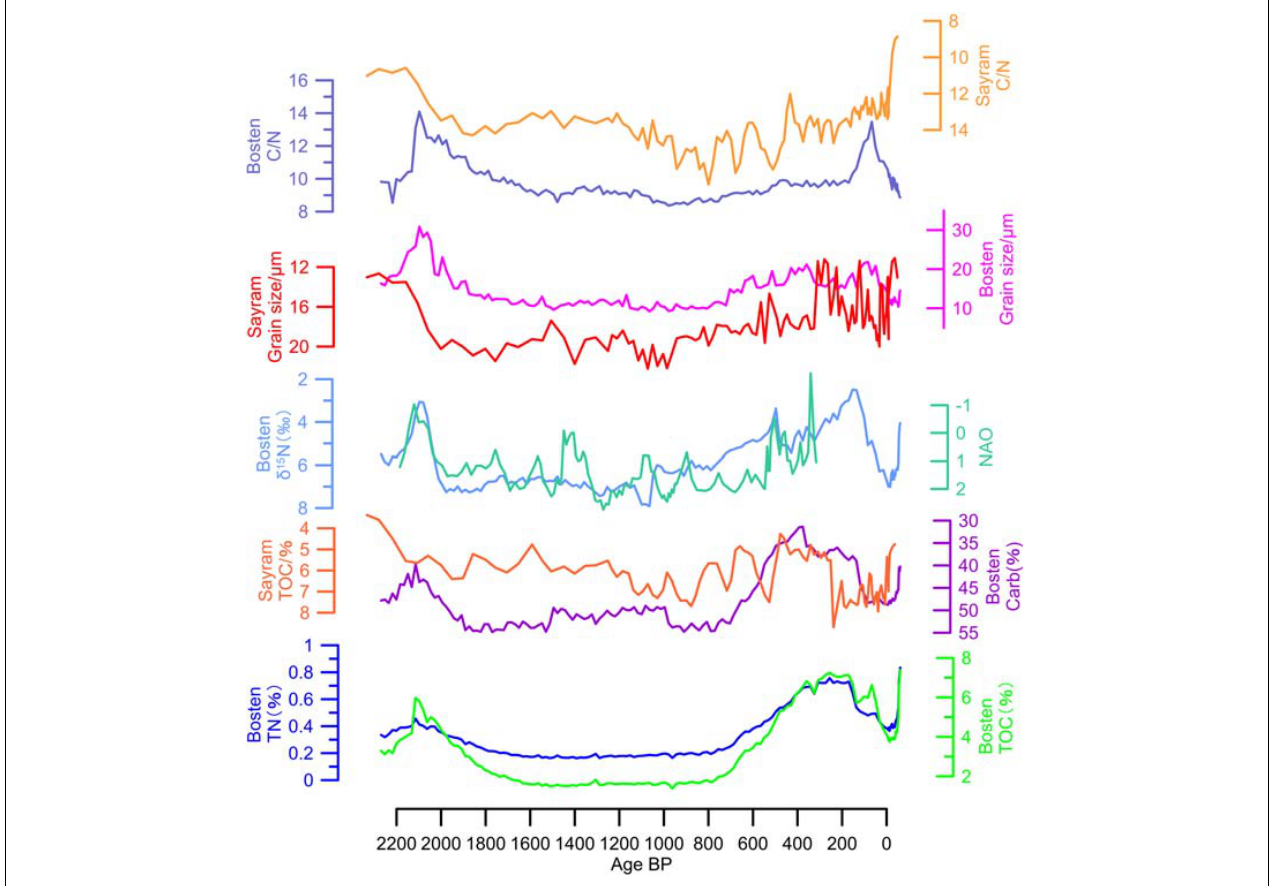
FIGURE 5 | Comparison between proxy indices in core BL13-1-4 in Lake Bosten (this study) and those from some other work. The grain size, C/N, and carbonate content were from Lan et al. (2019) and NAO index is from Olsen et al.